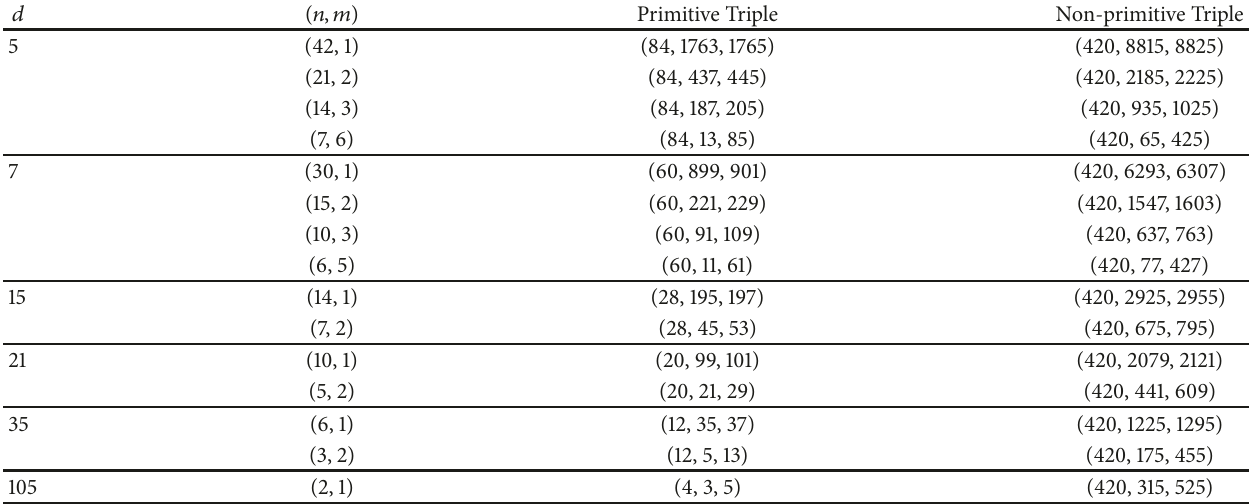
Table 6: Nonprimitive Pythagorean triples with common leg 𝑎 = 420 for each odd value of 𝑑 .